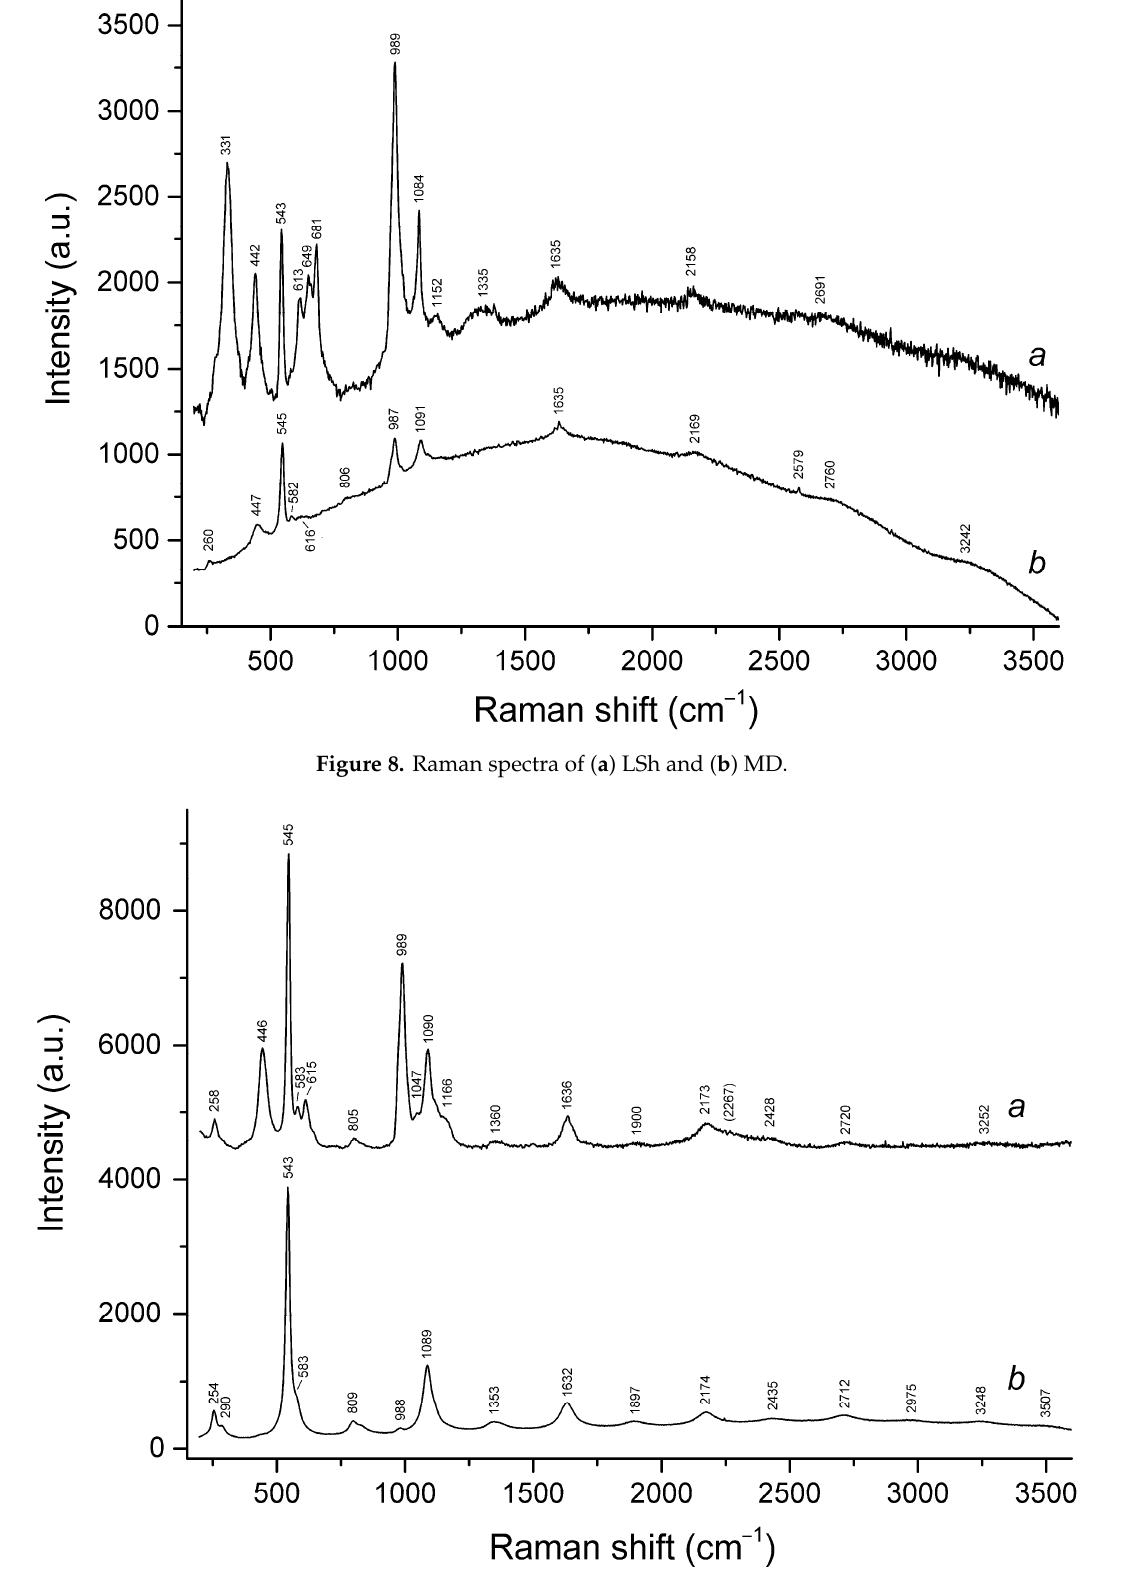
Figure 9. Raman spectra of ( a ) Hn7981 and ( b ) PH.